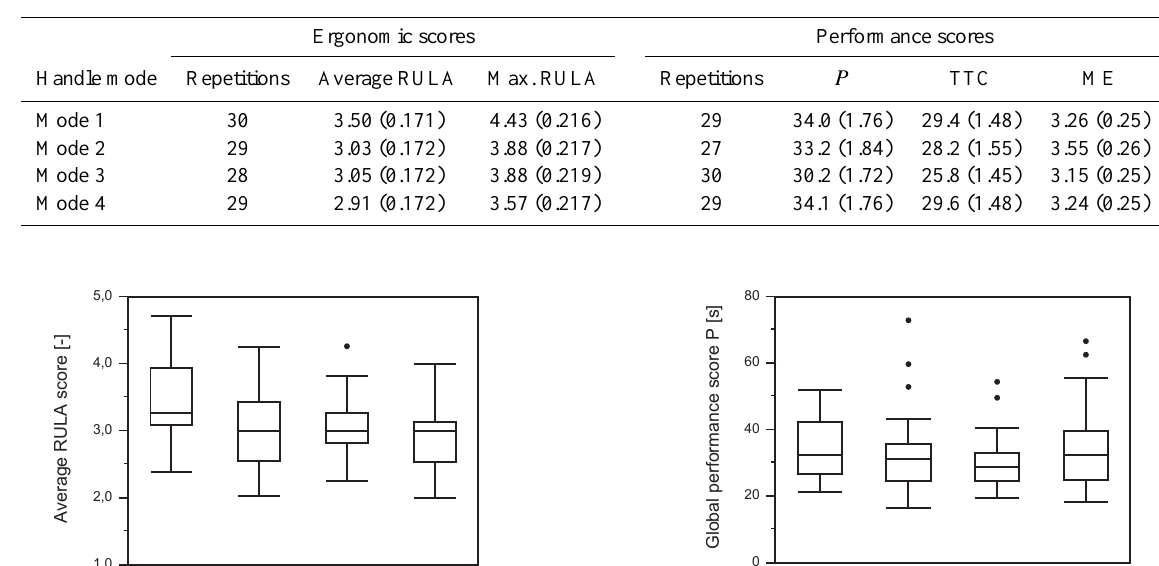
Table 1. Least-squares means and standard errors modeled by ANOVA for each handle mode.